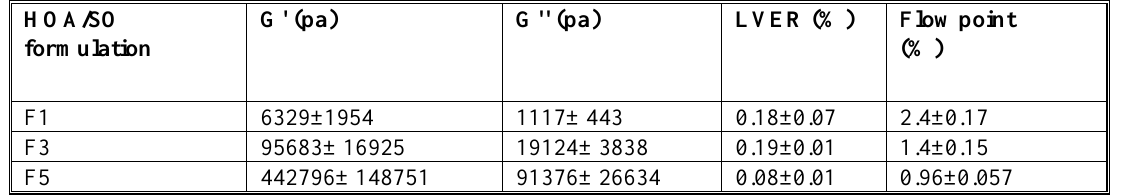
Table 2 . The amplitude sweep parameters for HOA in SO as each value represent the average of 3 values (n=3) ±